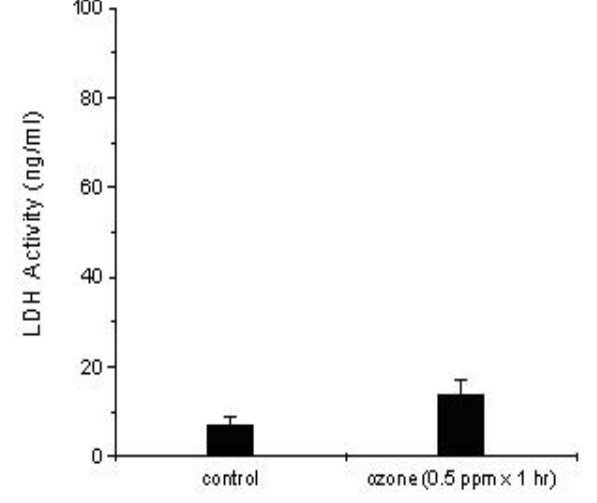
Figure 2: Cytotoxic Effect of Ozone on A549 Cell Membrane Integrity . Confluent A549 cultures were exposed to ozone at a concentration of 0.5 ppm for 1 hr and lactate dehydrogenase activity (LDH) was measured as an indicator of cell membrane integrity. Data (ng/ml) of LDH are presented as mean ± SEM (n = 6, each group).